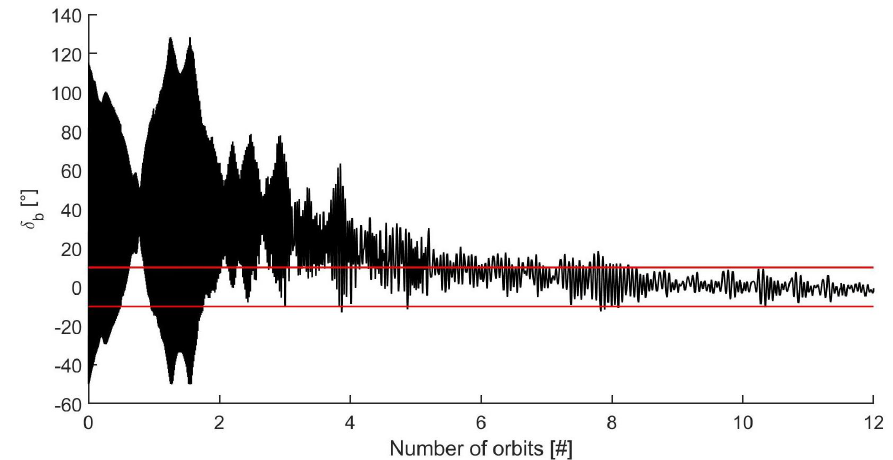
Figure 8. Misalignment error between ˆ z b and B b for PMACS with 1 permanent